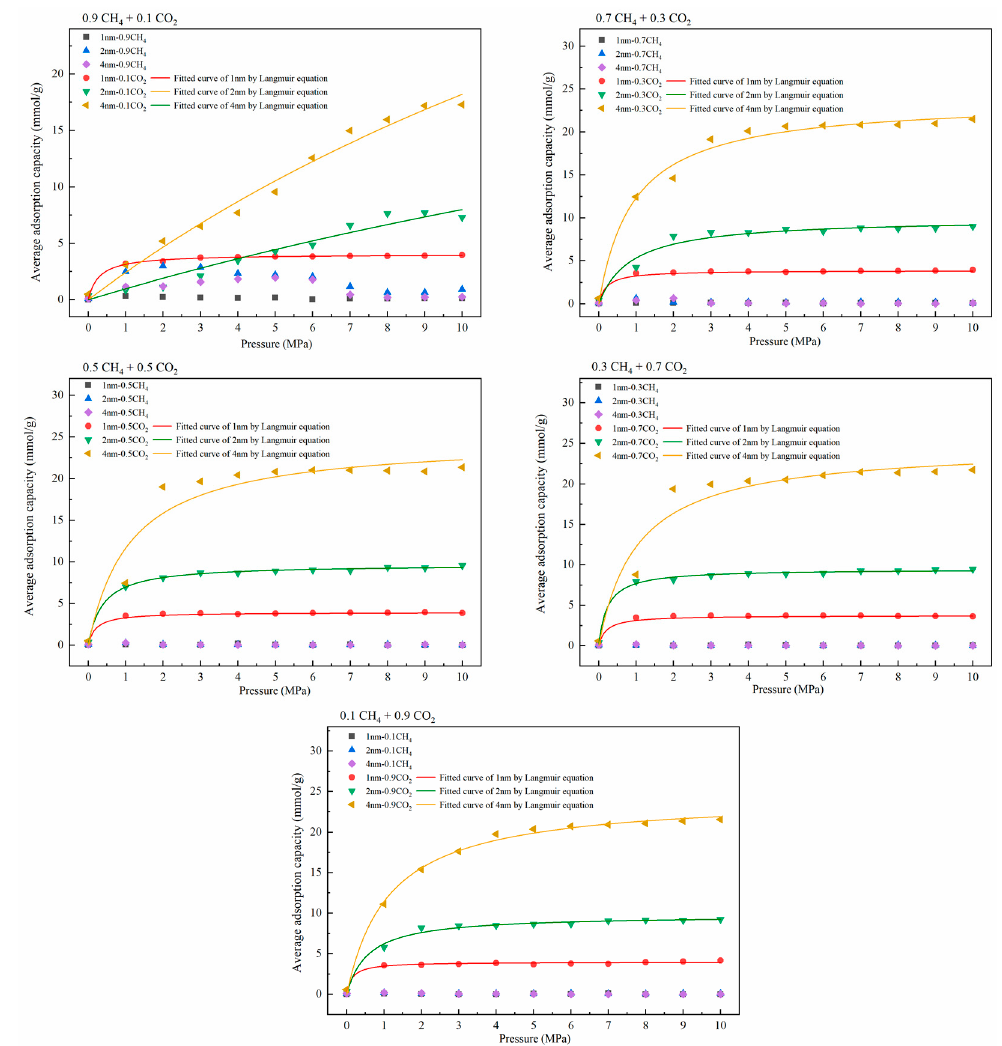
Figure 5. Adsorption isotherms of different ratios of CH 4 /CO 2 at 293.15 K.